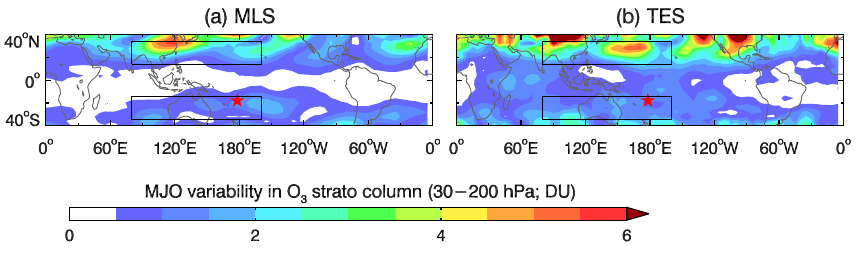
Fig. 5. The MJO variability in O 3 columns derived from MLS and TES observations. The variability is defined as 2 standard deviations of the MJO cycle (see text). The location of Fiji (178.4 ◦ E, 18.13 ◦ S) is represented by ( ? ). The rectangular boxes enclose representative subtropical regions (80 ◦ E–200 ◦ E, 14 ◦ N/S –34 ◦ N/S) where the MJO modulations are largest.